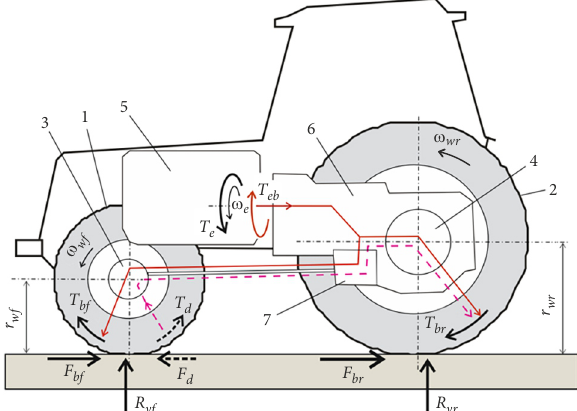
Figure 1. Kinematic diagram of engine-braked MFWD tractor when there is power circulation between the front and rear wheels: 1, 2 – front and rear wheels; 3, 4 – front and rear driving axles; 5 – engine; 6 – transmission (gearbox); 7 – front axle driving mechanism (distribution